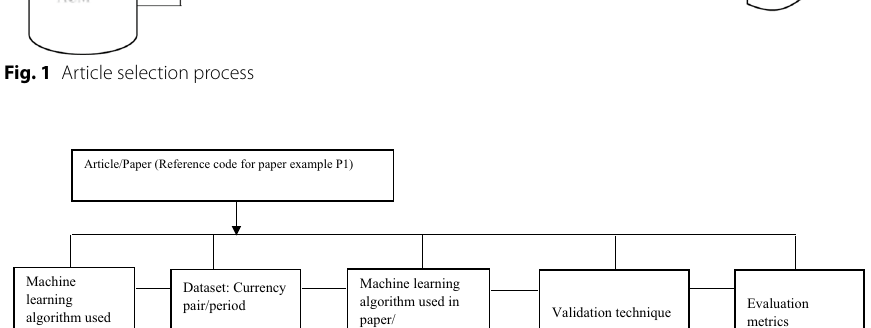
Fig. 1 Article selection process